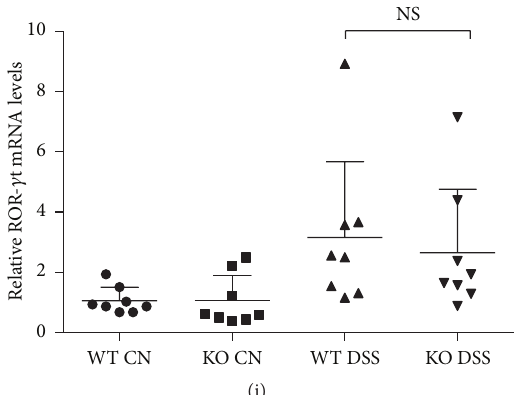
Figure 3: Analysis of the mRNA expression of cytokines and transcription factors for Th cells in the colons of TRAF5 KO and WT mice. (a) TNF- 𝛼 , (b) IFN- 𝛾 , (c) IL-4, (d) IL-17a, (e) IL-22, (f) T-bet, (g) GATA-3, (h) ROR- 𝛼 , and (i) ROR- 𝛾 t mRNA expression levels were determined by real-time PCR. The data are representative of 3 independent experiments (mean ± SD). 𝑁 = 8 per group. ∗ 𝑝 < 0.05 versus the DSS-treated WT group; ∗∗ 𝑝 < 0.01 versus the DSS-treated WT group. NS: not significant versus the DSS-treated WT